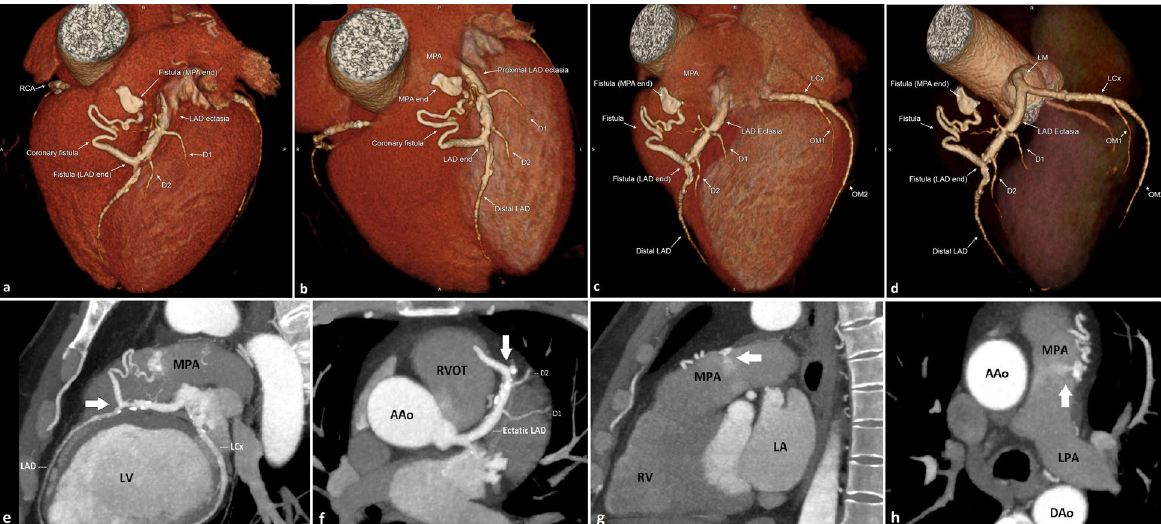
Fig. 2 Sizeable proximal LAD coronary artery fistula with MPA in 52-year-old male patient with typical chest pain. 3D volume rendered images ( a–c ) showing sizeable tortuous coronary artery fistula arising from ectatic proximal LAD and draining into MPA by sizably noted contrast blush. Tilted semitransparent 3D volume rendered image ( d ) shows the vessel of origin, fistula size and course and draining site as well. Sagittal oblique MIP image ( e ) showing the sizeable coronary artery fistula arising from ectatic proximal LAD (arrow) attaining tortuous course and draining into MPA with atherosclerotic plaques noted within LAD as well. Axial MIP image ( f ) shows the vessel of origin clearly (arrow). Sagittal oblique and axial MIP images ( g , h ) show abnormal contrast jet inside MPA (arrows) at the site of fistulous